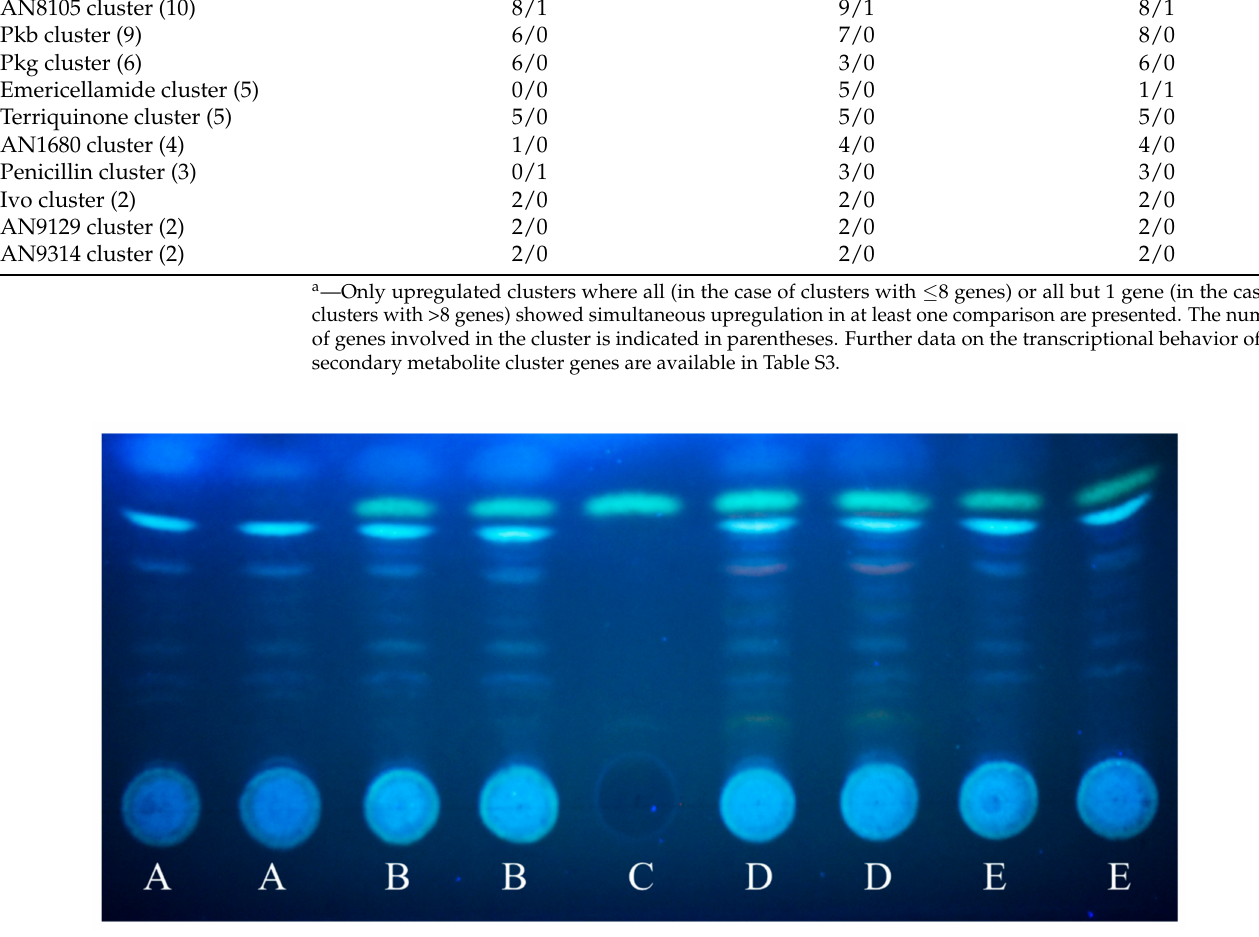
Figure 4. Production of sterigmatocystin by carbon-stressed A. nidulans THS30 cultures. A represen- tative photo on the results of a TLC is presented. Mycelial samples were taken 12 h (carbon-stressed cultures) or 4 h (glucose-containing cultures) after the mycelia, grown on glucose, were transferred into fresh media. A—glucose-containing cultures; B—carbon-starved cultures; C—sterigmatocystin standard; D—lactose-containing cultures; E—arabinogalactan-containing